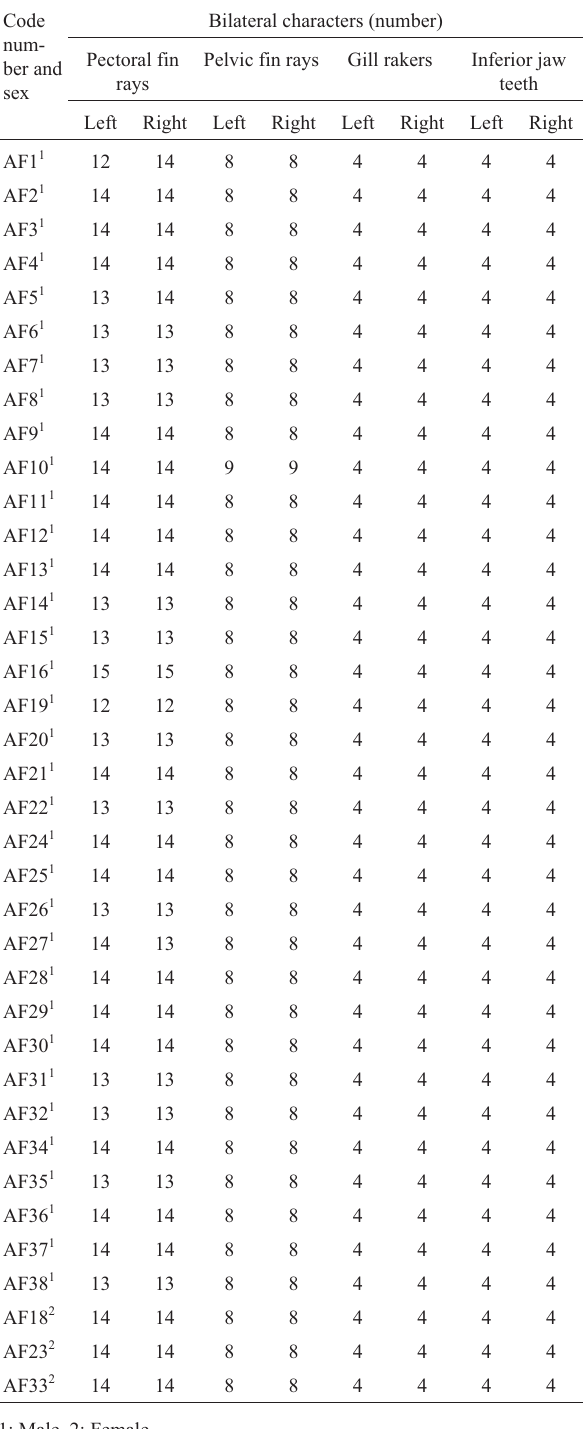
Table 2 - Meristic data for the Tibagi river Astyanax specimens and the bilateral characters used for fluctuating asymmetry analysis. Code num-